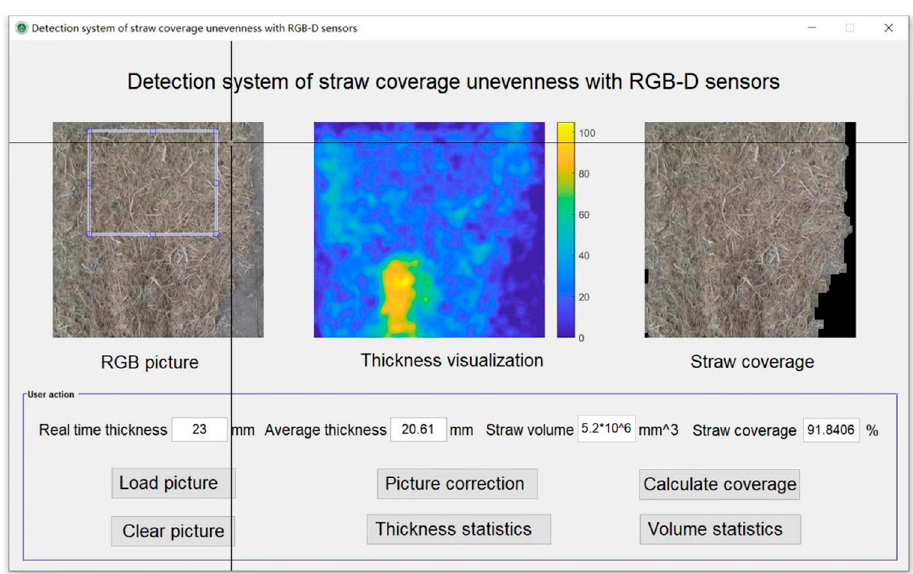
Figure 4. Detection system of straw coverage unevenness with RGB-D sensors.